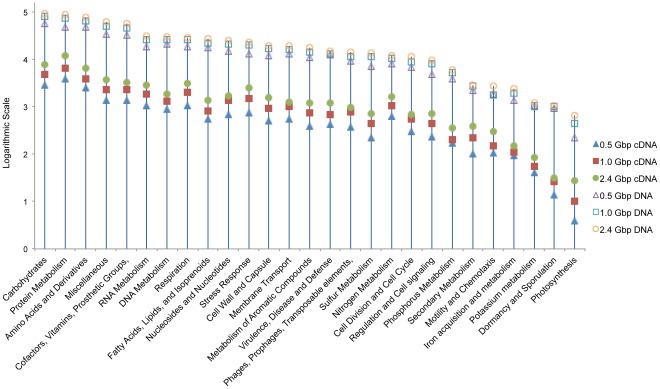
Gene expression classification based on automated SEED subsystem in MG-RAST.Total six datasets were annotated by Level 1 subsystems.